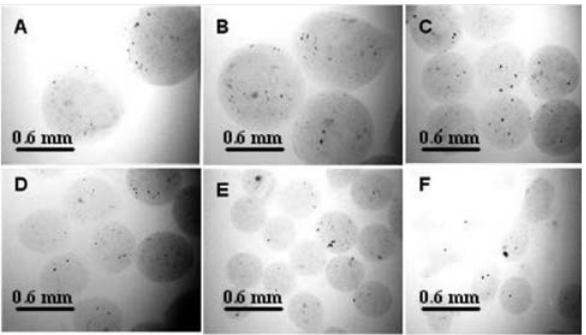
Figure 2 - Shape and size of particles obtained with different air jet flows and peristaltic pump rates. a) 1.15 mm ± 0.05 mm microcapsules, airflow 5 L min -1 , peristaltic flow rate 100 mL h -1 ; b) 1.15 mm ± 0.05 mm microcapsules, airflow 5 L min -1 , peristaltic pump rate 180 mL h -1 ; c) 0.6 mm ± 0.05 mm microcapsules, airflow 10L min -1 , peristaltic pump rate 100 mL h -1 ; d) 0.6 mm ± 0.05 mm microcapsules, airflow 10 L min -1 , peristaltic pump rate 180 mL h -1 ; e) 0.4 mm ± 0.05 mm microcapsules, air- flow 15 L min -1 , peristaltic pump rate 100 mL h -1 ; and f) 0.4 mm ± 0.05 mm microcapsules, airflow 15 L min -1 peristaltic pump rate 180 mL h -1